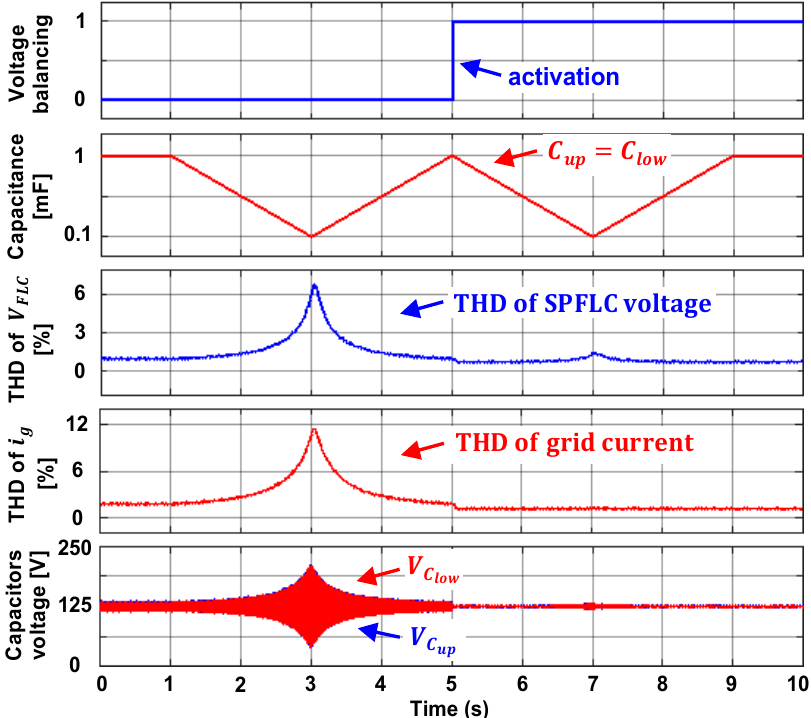
Figure 10. Dynamic response of the voltage balancing strategy and the vector control for the proposed grid-tied SPFLC during a sweep of the capacitance of the DC-link split capacitors.